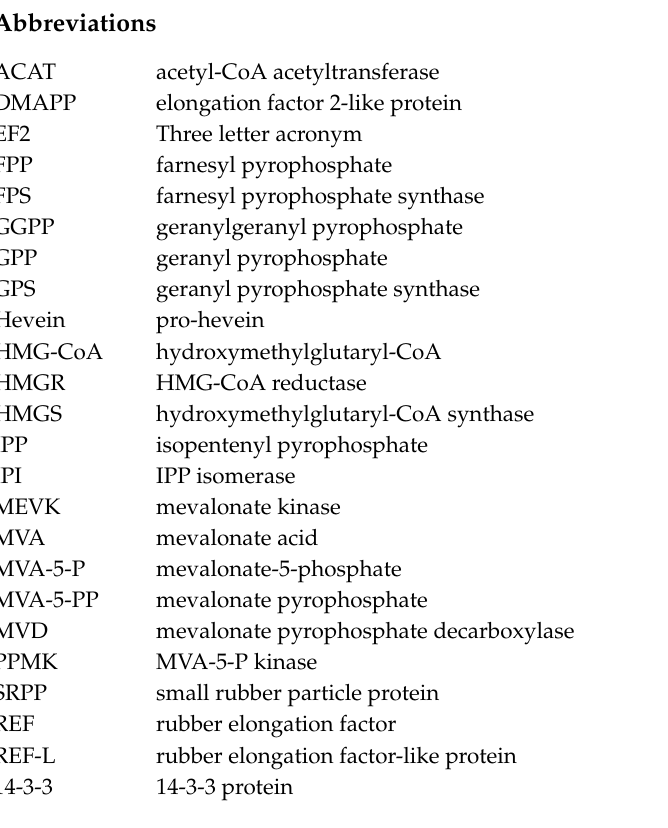
Figure S1: Detail information for MS identification of proteins in the 2-DE gel of the glycosylation spots; Table S1: All proteins identified from 2-DE gels and the potential functions; Table S2: Determination and functional analysis of the DAGPs in rubber latex upon ethylene